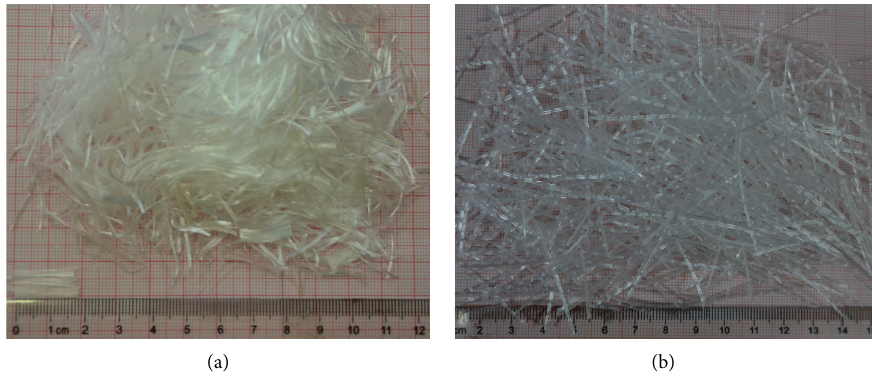
Figure 1: Polypropylene fibers: (a) fine PP fiber; (b) coarse PP